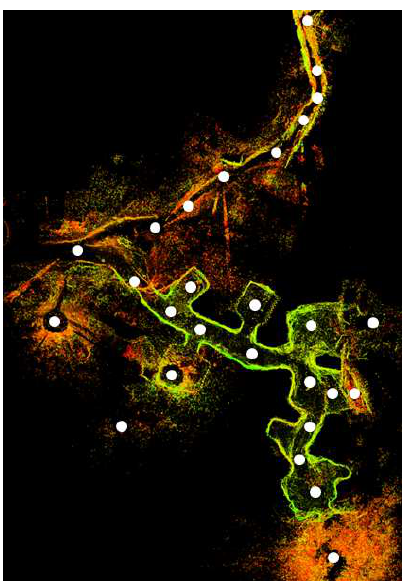
Figure 3. Scheme of laser-scanner scan points set up for the survey of the hypogeum area.